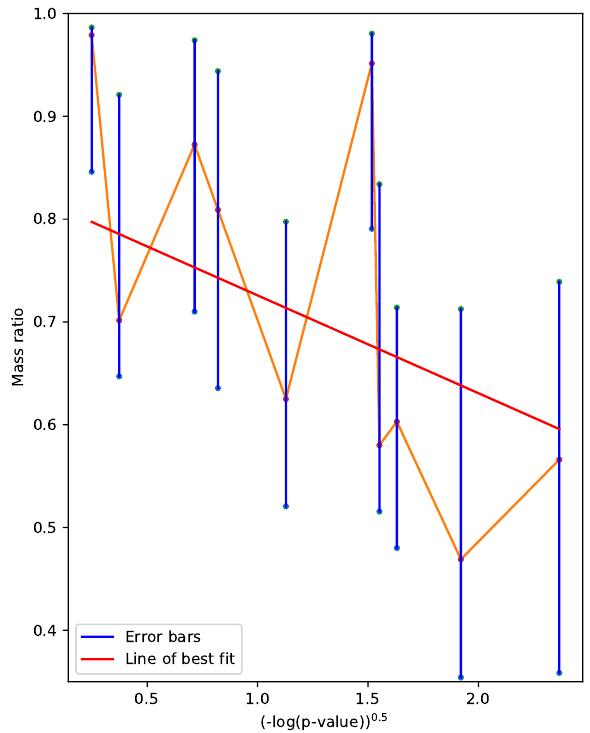
Figure 36. Plot of mass ratio dependence of p -values in [25]. Vertical lines are error bars for 50% credible region and central points are best value of mass ratio obtained from posteriors distribution. Because of relation of p -value to error function erf(SNR) we took roughly SNR horizontal axis [144].